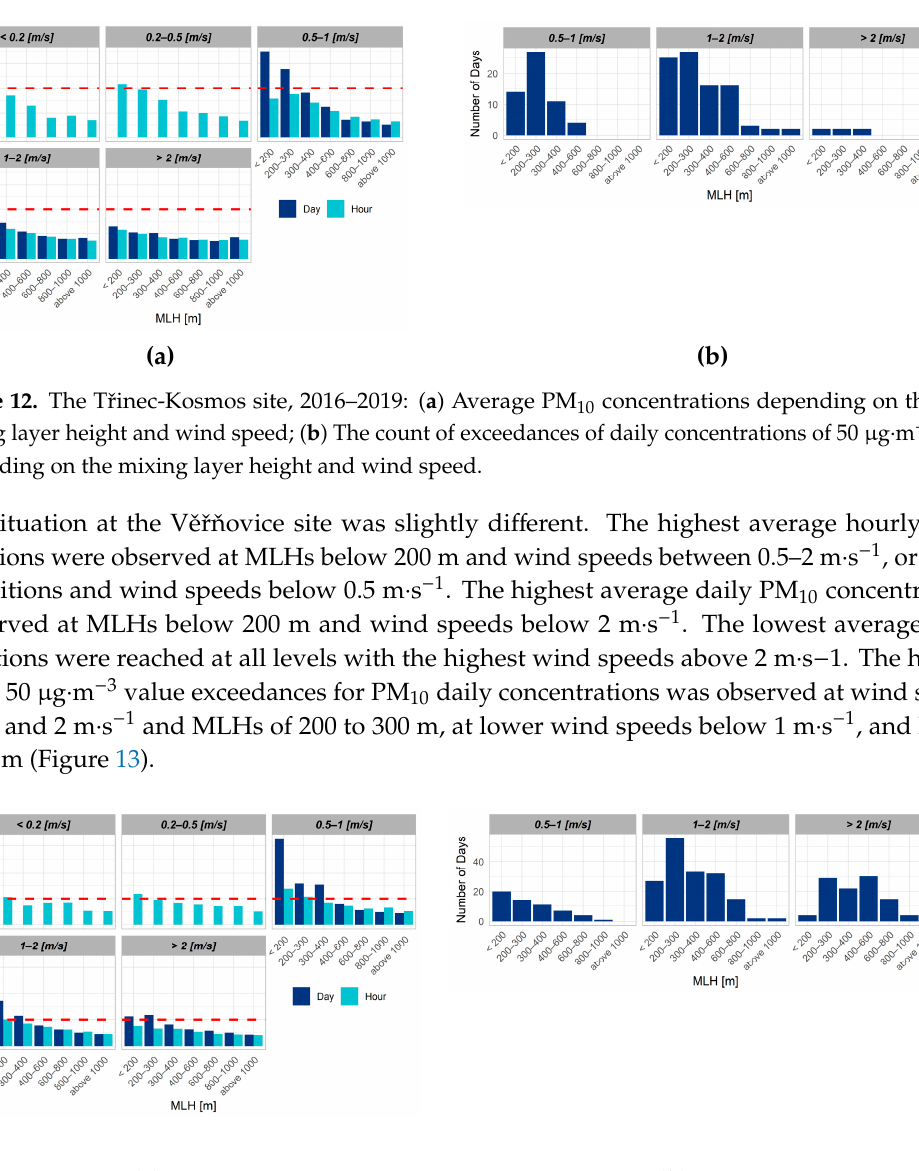
Figure 13. The V ěřň ovice site, 2016–2019: ( a ) Average PM 10 concentration depending on the mixing layer height and wind speed; ( b ) The count of exceedances of daily concentrations of 50 µg.m − 3 depending on the mixing layer height and wind speed.